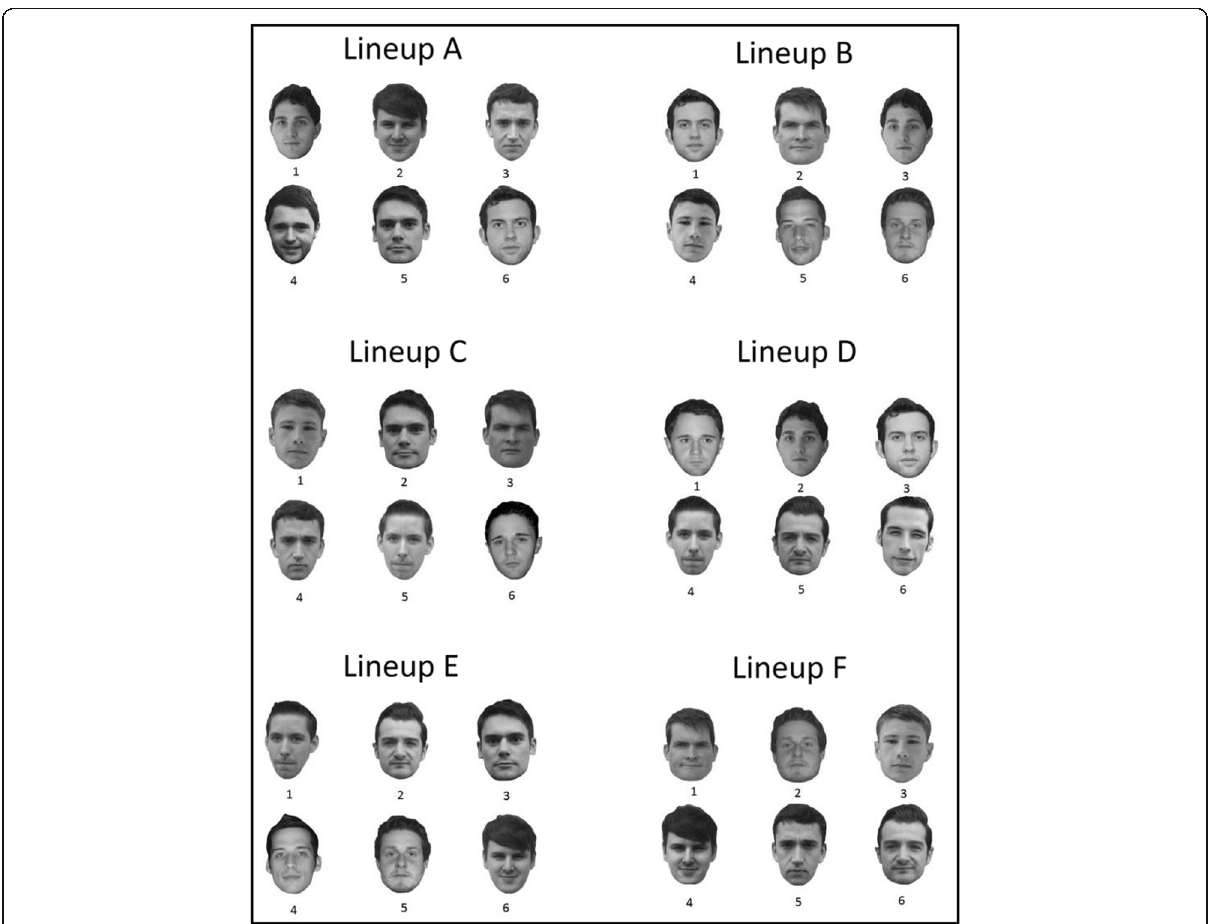
Fig. 1 Illustration of the face images in Experiment 1, depicting target-present lineups ( a , c , e ) and target-absent lineups ( b , d , f